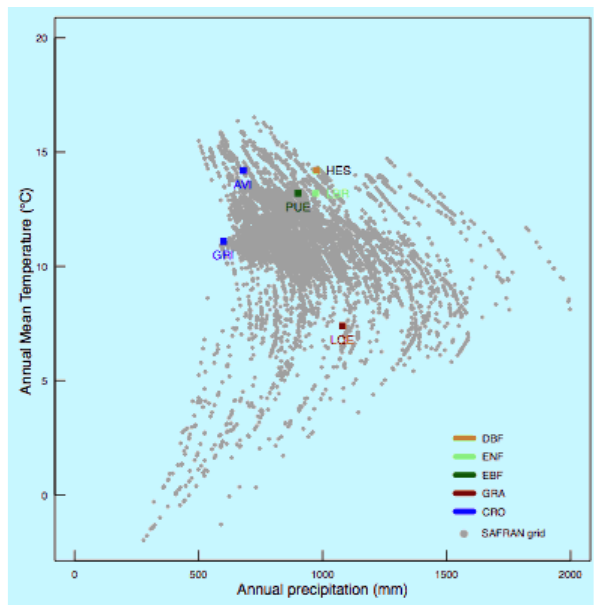
Fig. 1. The ecosystem types (DBF=deciduous broad-leaved for- est, EBF=evergreen broad-leaved forest, ENF=evergreen needle- leaved forest, CRO=cropland, GRA=grassland) of six selected flux sites over France in the climatic space: mean temperature versus annual precipitation, which are calculated as the mean of SAFRAN results over 1994 to 2007. The observed mean tempera- ture and annual precipitation at each site is indicated. The six sites are: Hesse (HES), Pu´echabon (PUE), La Bray (LBR), Laqueuile (LQE), Avignon (AVI) and Grignon